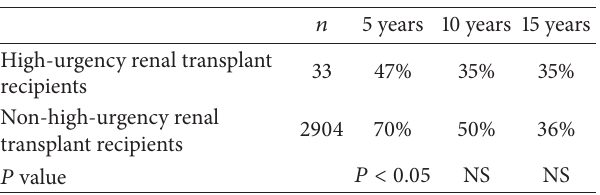
𝑛 5 years 10 years 15 years